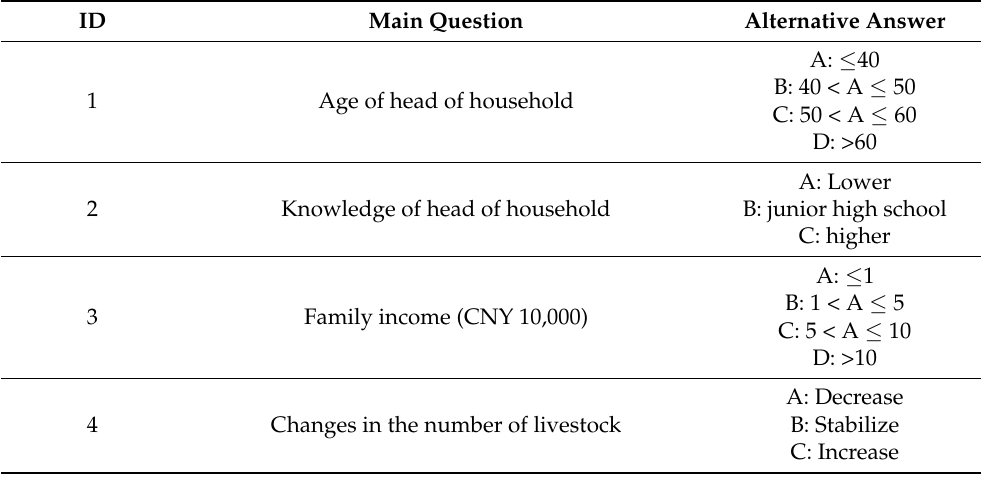
Table A1. Main Content of the